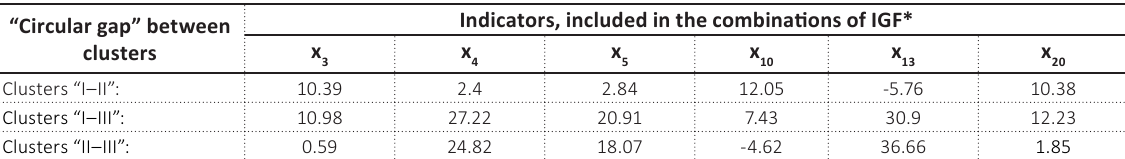
Table 5. Difference between the harmonic mean of the indicators, included in the combinations of IGF, as an assessment of “circular gap” between the clusters of the EU countries* “Circular gap” between